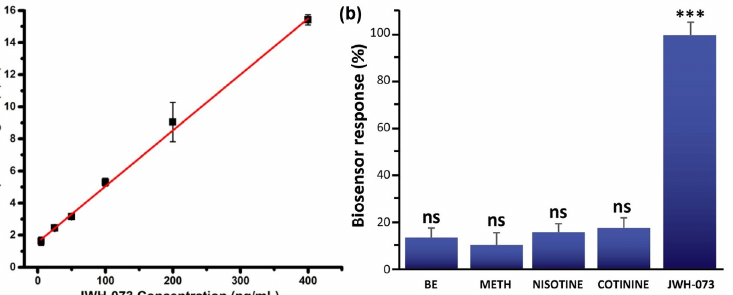
Figure 12. ( a ) Response signal of the MNP-K2 sensor at various JWH-073 concentrations. ( b ) Response of the sensor to certain potential interferents (ns: nonsignificant, *** p < 0.001 vs. SPE/MNP-K2). Adapted with permission from reference [40]. Copyright 2020 American Chemical Society.